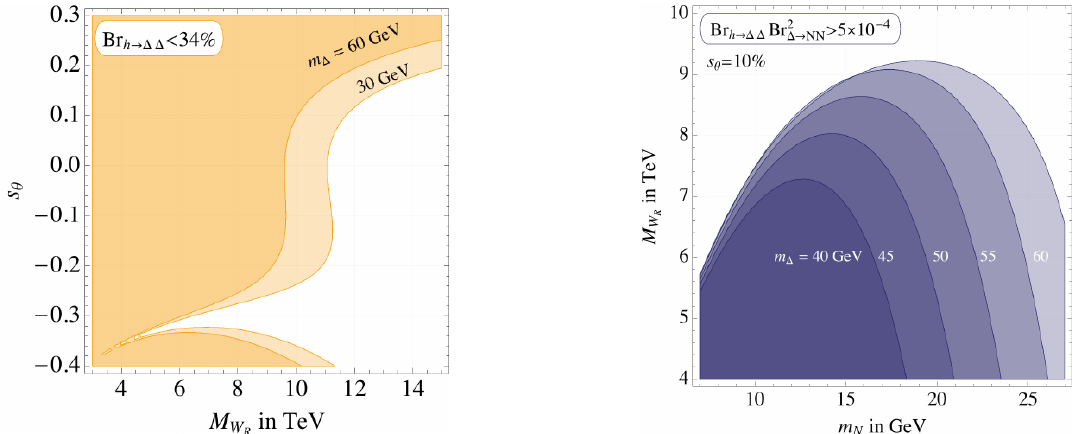
Figure 2 . Left: regions of h ! (cid:1)(cid:1) allowed by the current Higgs data [73] with m H = 17 TeV and r ++ = 0 : 3. Right: regions of larger than 5 (cid:2) 10 (cid:0) 4 branching ratio of Higgs decaying to four Majorana neutrinos. Contours correspond to di(cid:11)erent m (cid:1) and s (cid:18) = 10%. the h ! (cid:1)(cid:1) rate becomes sizeable ((cid:12)gure 2, left). Since the (cid:1) proceeds to decay to pairs of N s, one ends up with quite an exotic Higgs decay to four Majorana neutrinos. The relevant quantity that sets the event rate is the Br (cid:12)gure